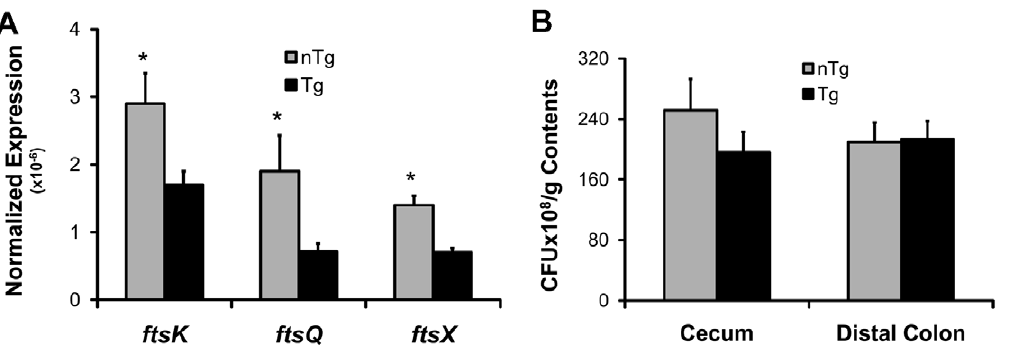
Figure 5. Expression of Cell-Division Genes and Bacterial Density in Cecal Contents from B. theta Monoassociated Rats. (A) Normalized expression of fts cell-division genes relative to bacterial 16S rRNA in B. theta from ceca of 6-week monoassociated rats. (B) Colony forming units (CFU)/g cecal contents from 6-week monoassociated non-transgenic (nTg) and HLA-B27 transgenic (Tg) rats (mean + SD, n=4–5 rats/group, *p ,